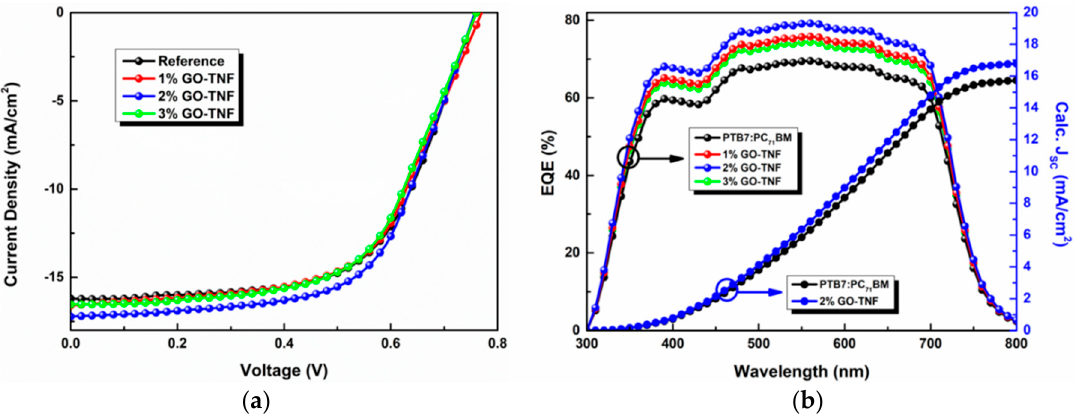
Figure 10. J-V characteristics ( a ) and EQE curves ( b ) of the reference (PTB7:PC 71 BM) and the devices incorporating different GO-TNF ink content. The calculated J sc curves (inset in EQE) correspond to the reference and the champion device with 2% GO-TNF ink content.